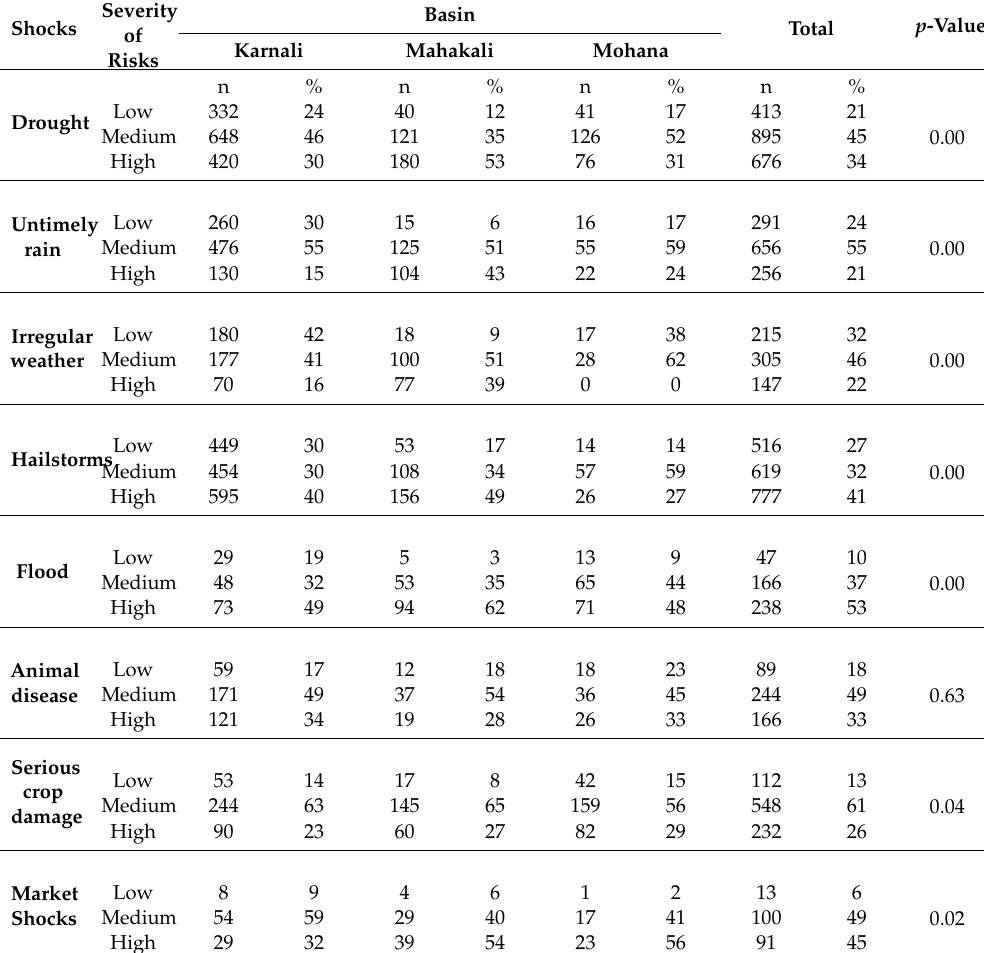
Figure 4. Percentage of respondents perceiving different types of shocks in the last five years—( a ) across the entire Western Nepal; and ( b ) across the three ecological regions (i.e., mountain / hill / Tarai). Table 3. Severity of the risks to shocks perceived by households in the Karnali-Mahakali Basins. The p -values are based on Chi-squared test.